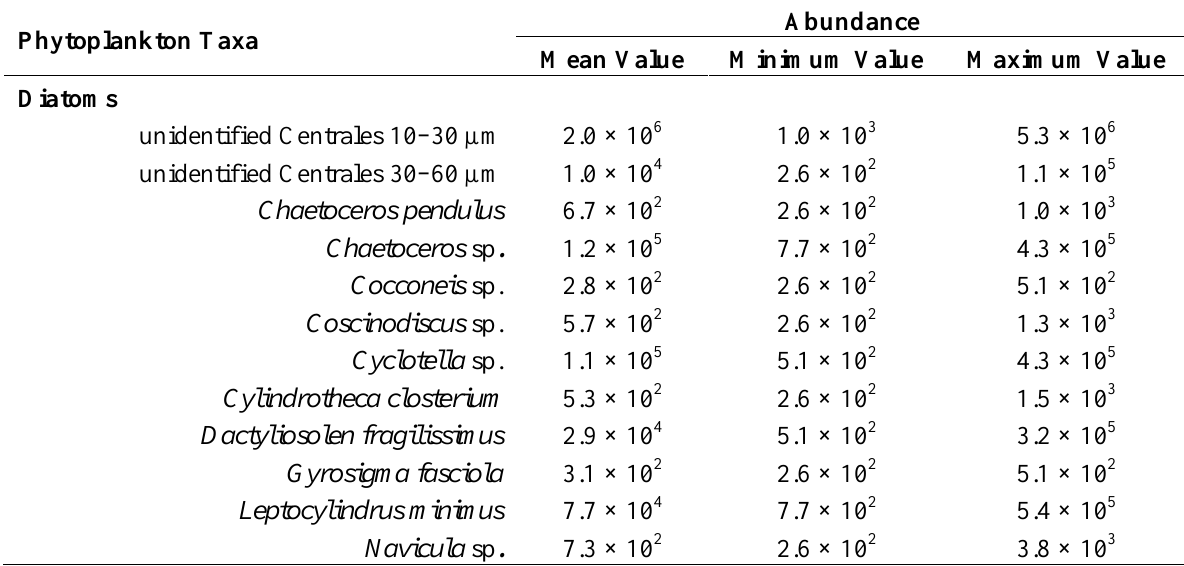
Table 1. Summary statistics of phytoplankton abundance data (cells L −1 ) of the 41 taxa observed in the Lafayette River samples at least 5 times during the study. The two bloom taxa are identified in